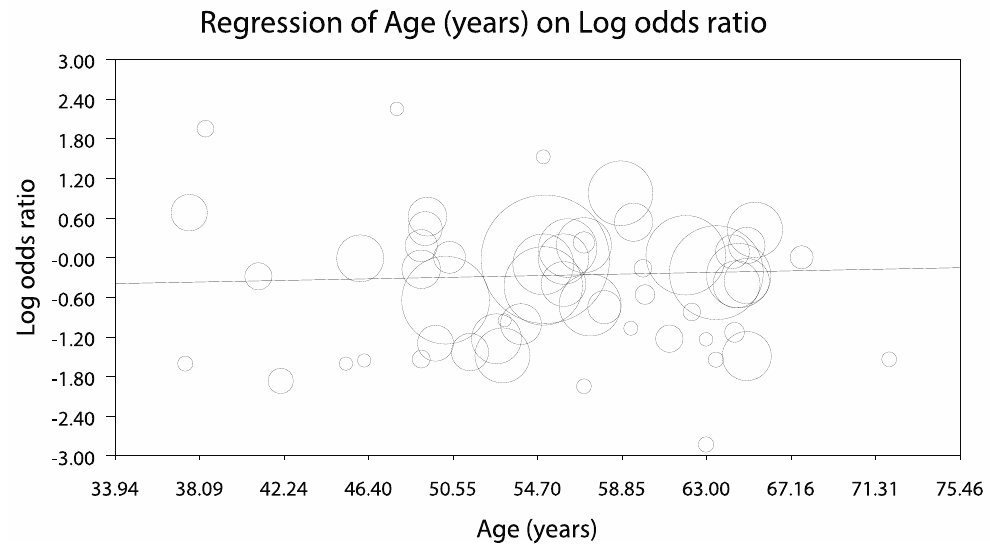
Figure A1. Meta-regression showing the impact of the rate of peripheral cannulation on Log odds ratio.